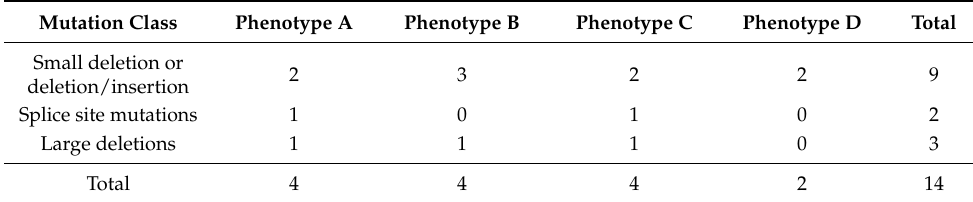
Figure 7. Scatterplots showing 10–2 (macular) and 37R (foveal) MAIA mean sensitivity (MS), spectral-domain optical coherence tomography (SD-OCT) ellipsoid zone (EZ) span and near-infrared autofluorescence (NIAF) hyperautofluorescent ring (HAR) area against age in all available patients, including serial measurement in some patients. Colours of markers indicate genotype groups including small deletion and deletion/insertion (Blue), splice site mutations (Green) and large deletions (Red). An overall decline of macular ( A ) and foveal ( B ) MS with increasing age was noted in the whole cohort. However, both methods showed short-term variations in individual patients. Both EZ span ( C ) and HAR area ( D ) showed age-dependent decline in those with available serial measurements. However, substantial variation was noted between patients and genotypes. Table 2. Allocation of patients to phenotype